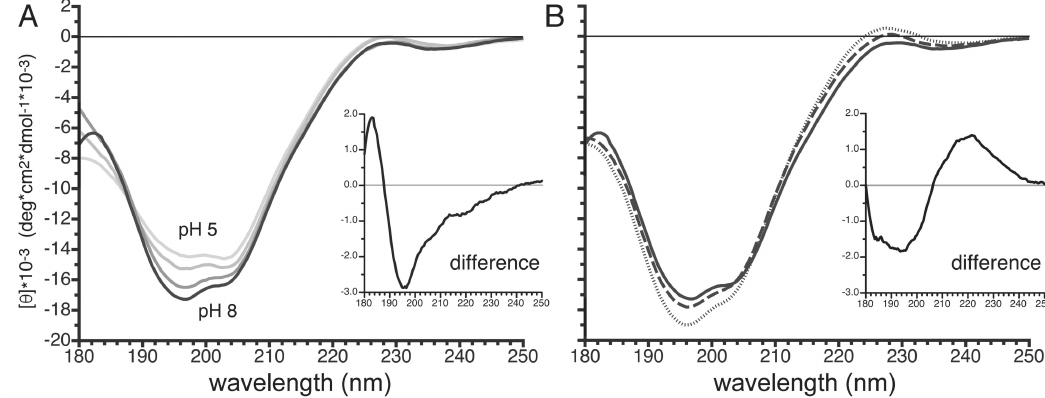
Figure 8. CD spectroscopy of the P. vulgaris TIP3;1 carboxy terminal domain. ( A ) Spectra collected with peptides at 50 µ M in bu ff er of 5mM sodium acetate pH 5.0 or in bu ff er of 5 mM sodium phosphate pH 6.0, 7.0, or 8.0 (line darkens with increasing pH) with sample at 25 ◦ C. Inset shows di ff erence between pH 5 and pH 8 spectra. ( B ) Spectra collected at pH 8.0, at a temperature of 5, 15, or 25 ◦ C (dotted, dashed, or solid line, respectively). Inset shows di ff erence between 25 ◦ C and 5 ◦ C spectra. CD signal shown in units of molar ellipticity [ θ ] (deg cm 2 / dmol). At pH 5 two strong negative peaks were observed at 203 nm (ellipticity − 14,600 deg cm 2 dmol − 1 ) and 197 nm (ellipticity − 14,500 deg cm 2 dmol − 1 ). As the pH was shifted to 8, the band at 197 nm became dominant, reaching a maximum of − 17,300 deg cm 2 dmol − 1 .